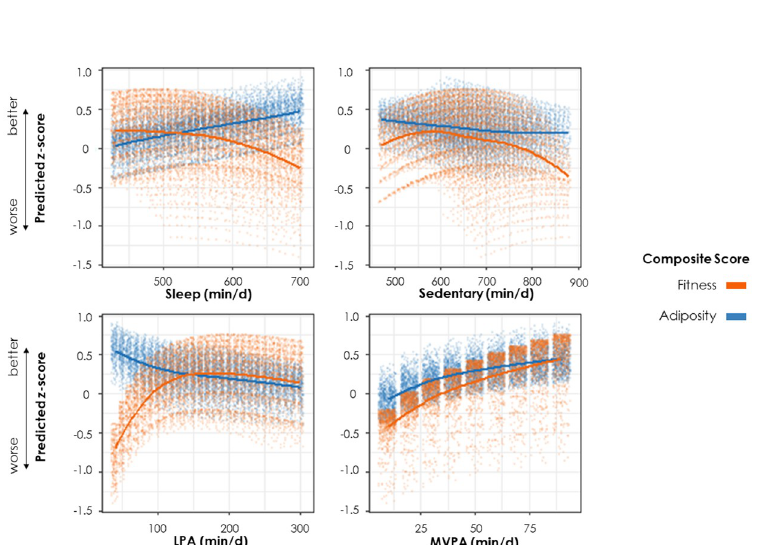
Fig 2. Relationship between incrementally increasing durations of individual activity behaviors and fitness/ adiposity composite summary z -score. Higher z -scores represent better outcomes. Adjusted for age, sex, puberty and socioeconomic position. Fitness additionally adjusted for body mass index z -score and included quadratic term for the activity composition. Note: Jitter was applied to data points to enable visualization of overlapping points. Each data point represents one of the possible permutations of activity compositions (in 10-min increments) within the study sample’s empirical activity footprint (i.e., the ranges of activity durations observed in the sample truncated at ± 3SD of univariate distributions of behaviors). Care must be taken when interpreting the relationship between individual activity behaviors and outcomes. Although we can describe the shape of relationships in terms of individual behaviors (e.g., MVPA is beneficially associated with outcomes), this description pertains to the average situation only, as shown by the loess line. There is substantial variation around this line because the observed relationship with the activity in question (e.g., MVPA) depends on the values of the remaining activity behaviors (e.g., sleep, sedentary time and LPA). LPA = light physical activity; MVPA = moderate-to-vigorous physical